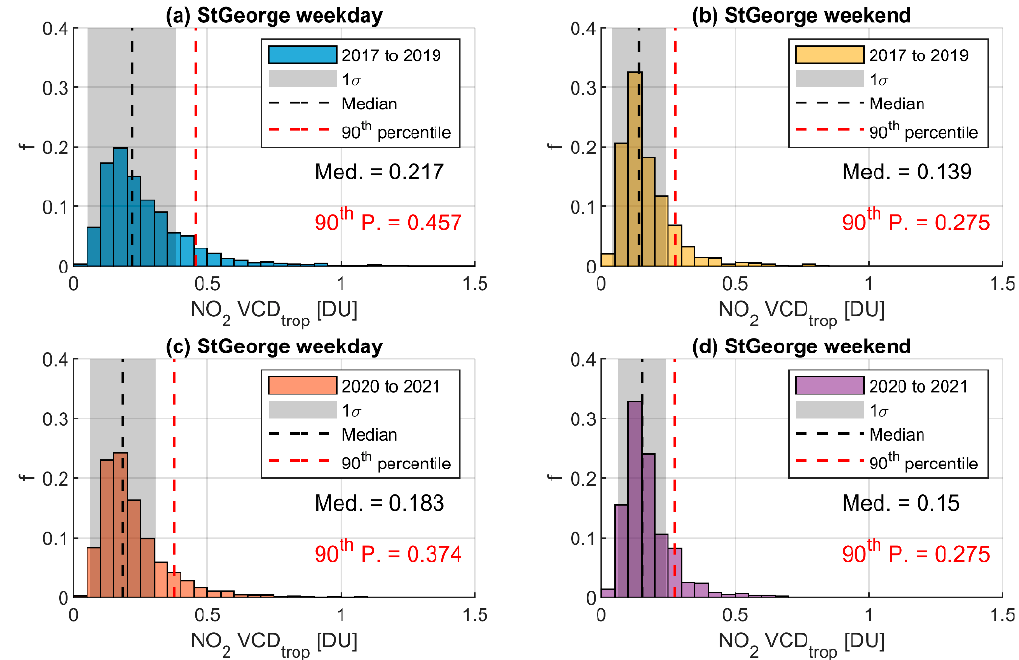
Figure 5. Histograms of NO 2 tropospheric column at UTSG site for observations from 15 March to 15 September of each year. ( a , b ) show weekday and weekend observations before the pandemic (2017–2019), respectively; ( c , d ) show weekday and weekend observations during the pandemic (2020–2021), respectively. The vertical black dashed line shows the median value of tropospheric NO 2 with shading area representing its standard deviation. The vertical red dashed line shows the 90th percentile of observed tropospheric NO 2 .